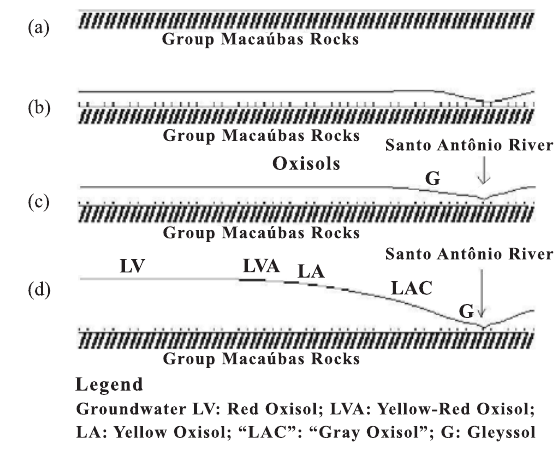
Figure 5. Landscape evolution model of the upper Jequitinhonha valley. (a) Schists of the Macaúbas Group exposed on an erosion surface; (b) Regolith formation and the beginning of the drainage network; (c) Oxisols formation from regolith exposed to the process of soil formation, especially oxide removal and transformation; (d) Deep incision of the drainage network, thickening of regolith and differentiation of